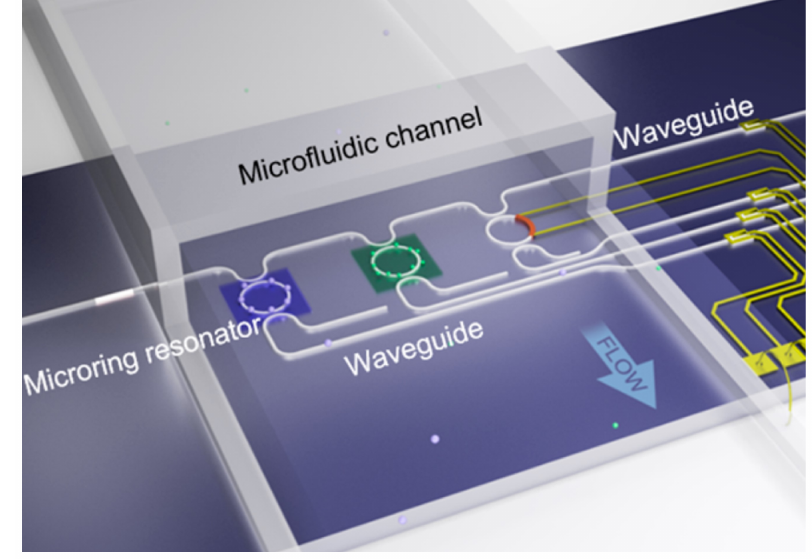
Figure 4. The optofluidic chip used to detect 2, 4-Dichlorophenoxyacetic